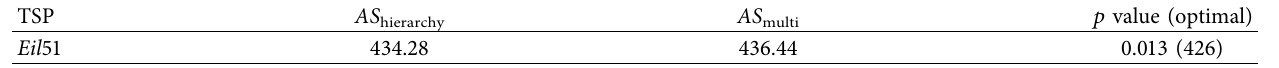
Table 3: Mean best solutions after parameter